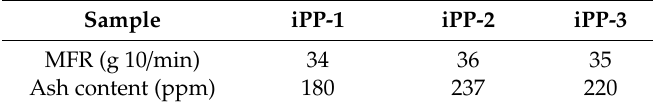
Figure 5. Rheological properties of the iPP samples. Table 5. Processing properties of the iPP samples.